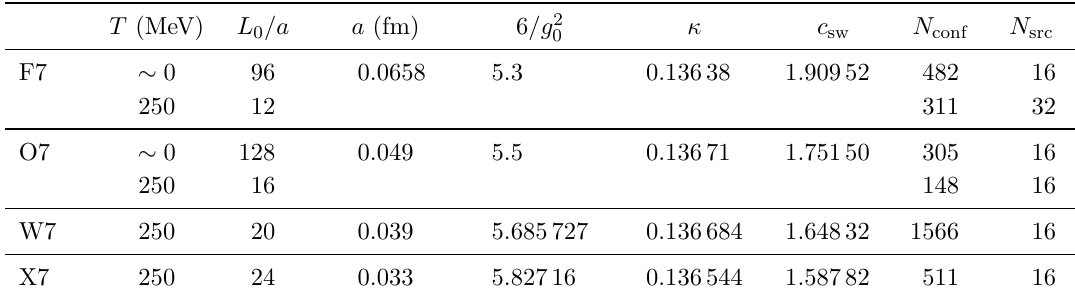
Table 4 . Simulation parameters for the investigation with N f = 2 non-perturbatively O( a )-improved Wilson fermions. For the ensembles W7 and X7, the tuning to the line of constant physics defined by the temperature and the quark mass was performed in ref. [22] using the Schrödinger functional coupling computed in ref.